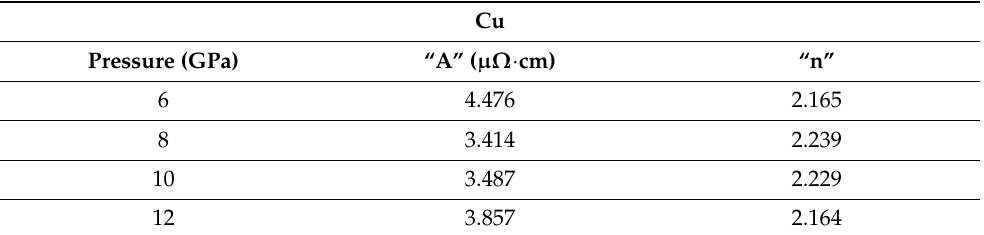
Table 1. Tabulated fitting parameters at various fixed pressures for Cu runs.